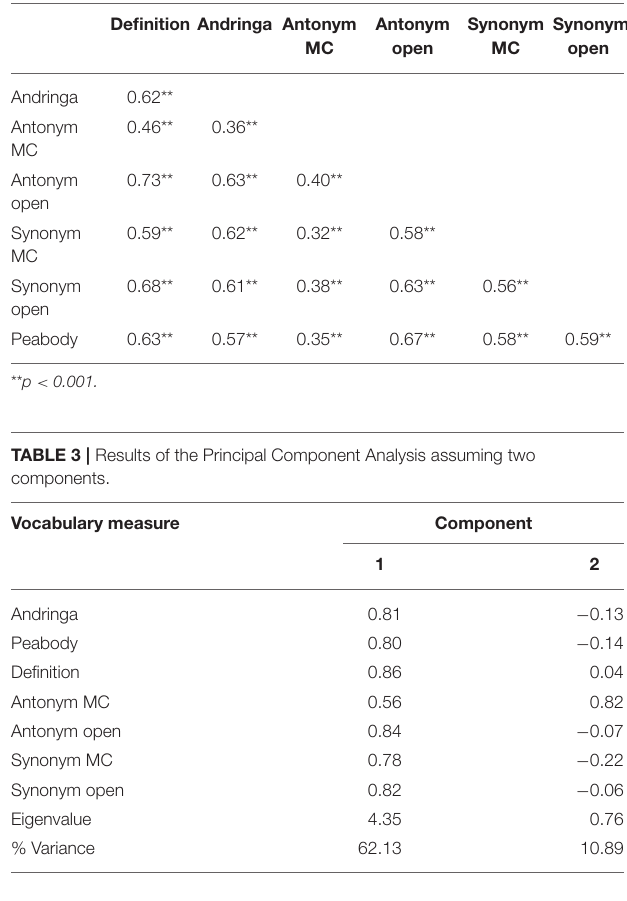
TABLE 2 | Correlations between the different vocabulary scores.